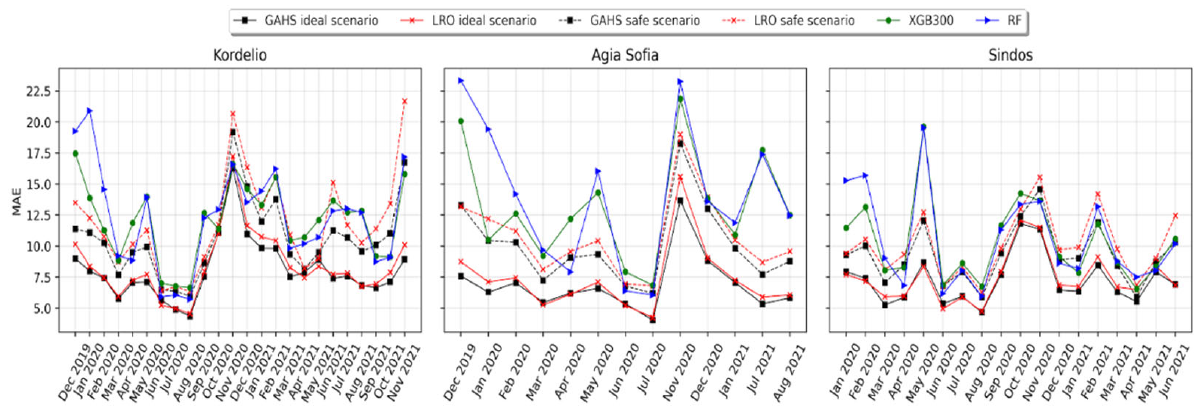
Figure 13. Comparison between the GAHS and the SOL frameworks along with two of the best performing batch models in terms of mean absolute error for PM 10 .